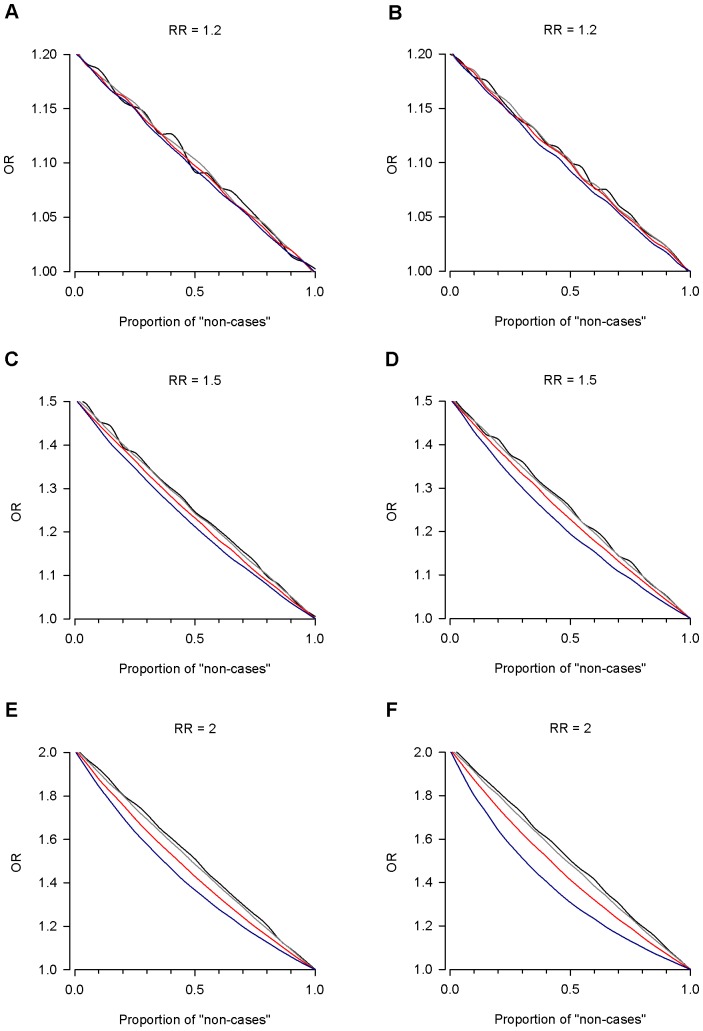
The impact of heterogeneity on the estimation of the genetic effect size.Odds ratios from simulated case-control data were calculated for each step of admixture. Data are reported for minor allele frequencies (MAF) of 0.01 (black), 0.05 (grey), 0.2 (red) and 0.5 (blue). The results are reported for dominant (panels A, C, and E) and multiplicative (panels B, D, and F) genetic models. RR = relative risk; OR = odds ratio.